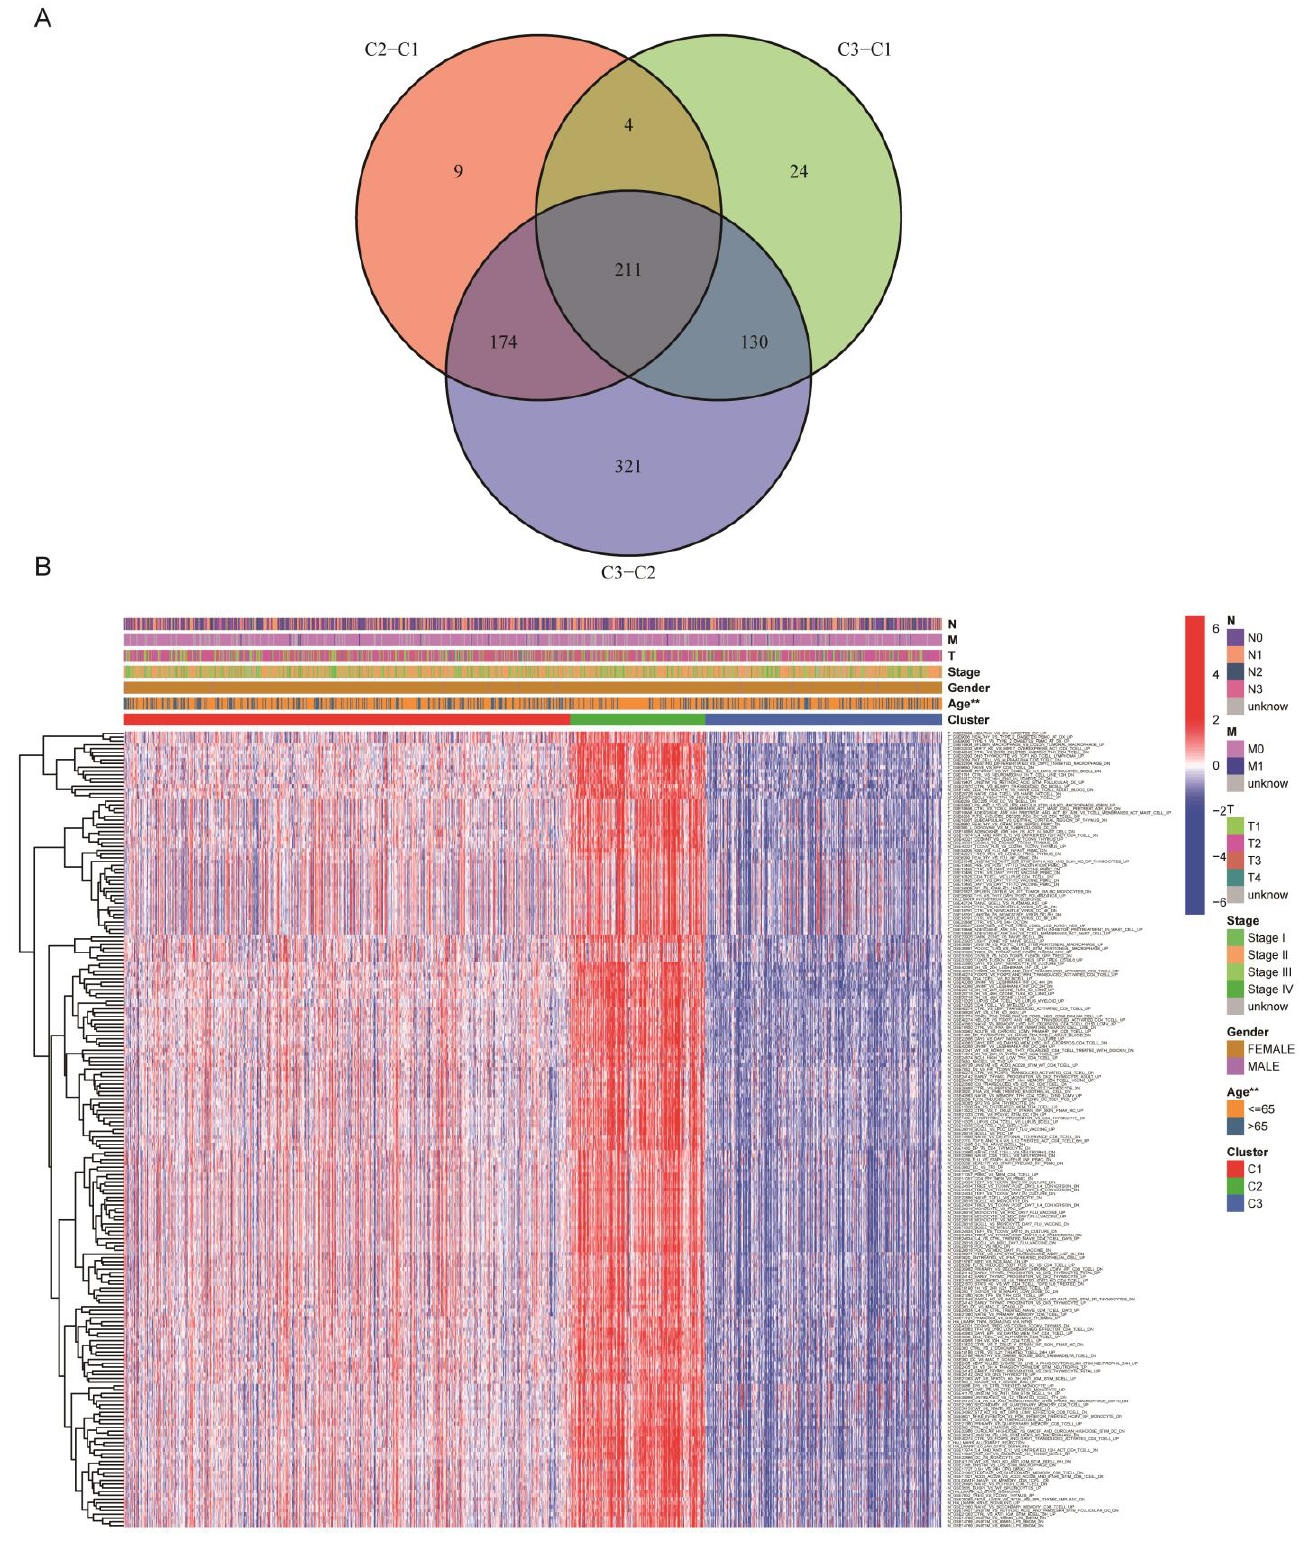
Figure 4. Identification of critical gene sets from BC subtypes. ( A ) A total of 211 differential gene sets were obtained by the differential enrichment score of gene sets between each of the two sub- types and taking intersections. ( B ) Gene sets and clinical associations are shown through heatmap. p < 0.01 = “**” .